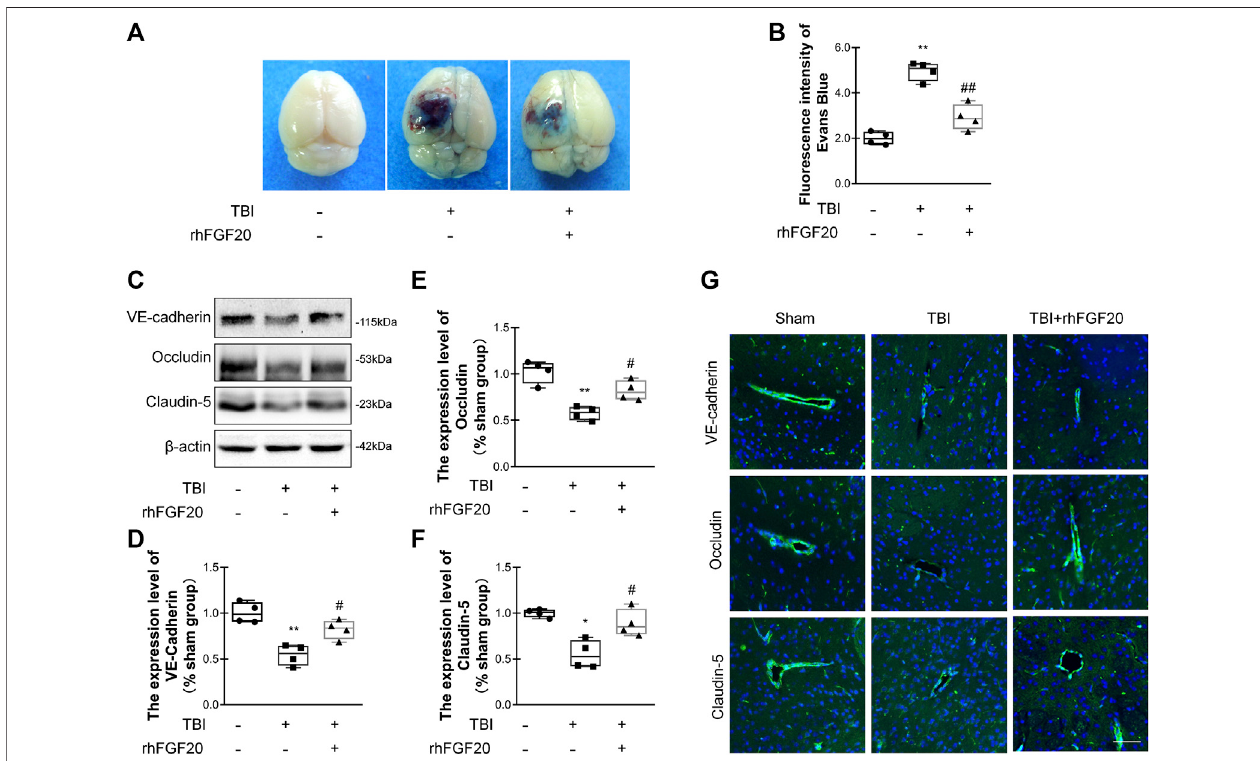
FIGURE 3 | Exogenous rhFGF20 protected against BBB disruption in the mouse brain 24 h after TBI (A) Representative images of Evans blue extravasation (B) Effects of rhFGF20 on Evans blue fl uorescence ( n (cid:1) 4) (C) Representative image of western blot analysis of VE-cadherin, Occludin, and Claudin-5. β -Actin was used astheloadingcontrolandforbanddensitynormalization (D – F) Quanti fi cationofwesternblottingdataforVE-cadherin,Occludin,andClaudin-5protein( n (cid:1) 4) (G) Effects of rhFGF20 on the expression ofthe VE-cadherin, Occludin, and Claudin-5 analyzed by immuno fl uorescence. The nucleiare labeled with DAPI ( n (cid:1) 4). Bar, 50 μ m. Magni fi cation, × 40. * p < 0.05, ** p < 0.01 vs. sham group. # p < 0.05, ## p < 0.01 vs. TBI group. Data are presented as the mean values ±